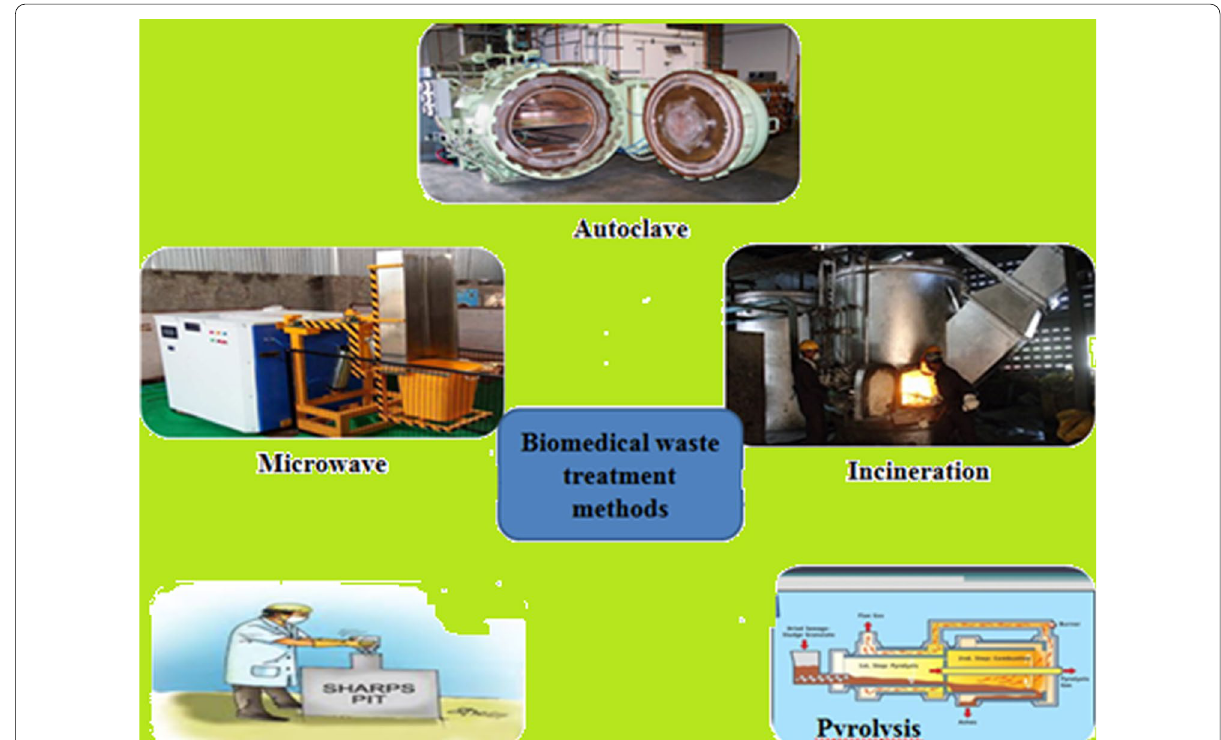
Fig. 2 Methods of biomedical waste